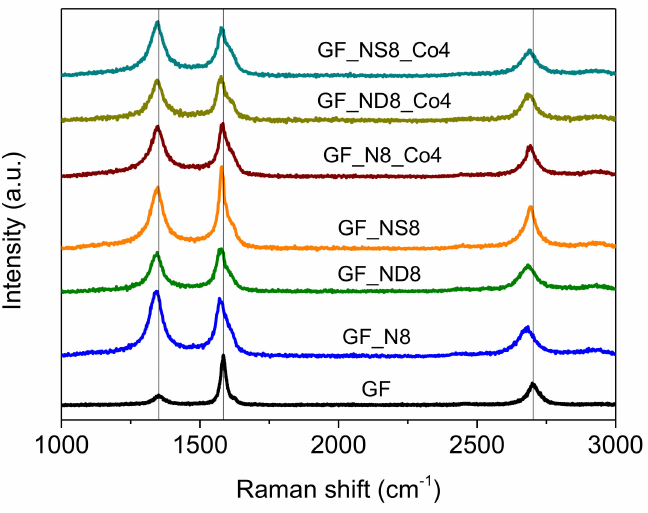
Figure 2. Raman spectra of the GF-based materials.